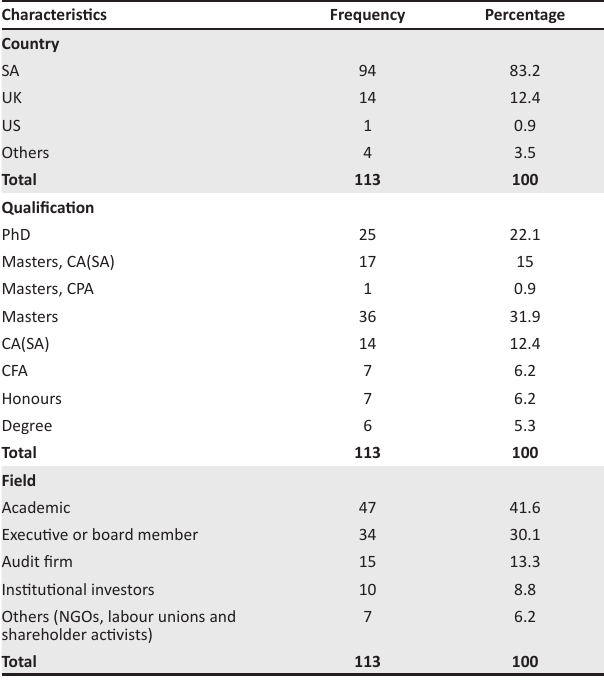
TABLE 1: Sociodemographic information of the